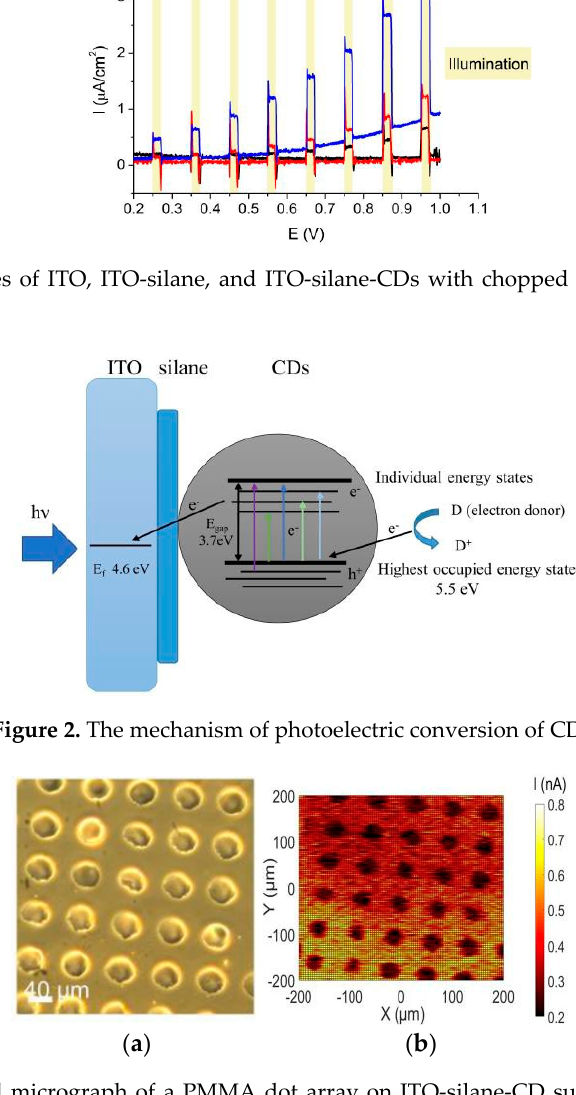
Figure 3. ( a ) Optical micrograph of a PMMA dot array on ITO-silane-CD surface by microcontact printing; ( b ) Corresponding ac-photocurrent image of ( a ) measured at 1.8